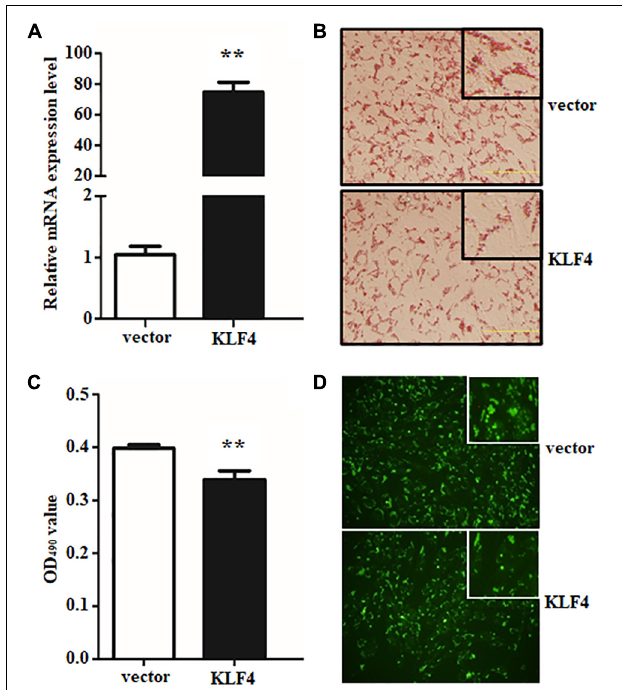
FIGURE 4 | Overexpression of KLF4 inhibits goat intramuscular adipocyte adipogenic differentiation. (A) KLF4 Overexpression efficiency detection at mRNA level mediated by adenovirus. (B–D) Representative images ( × 400). The Bodipy staining and Oil Red O staining and extracting between control and adenovirus treatment intramuscular adipocytes. ** p < 0.01 versus the negative control (vector) groups. Data are presented as mean values ± SD. Each experiment was performed at least in triplicate, producing consistent results. * p < 0.05, ** p <